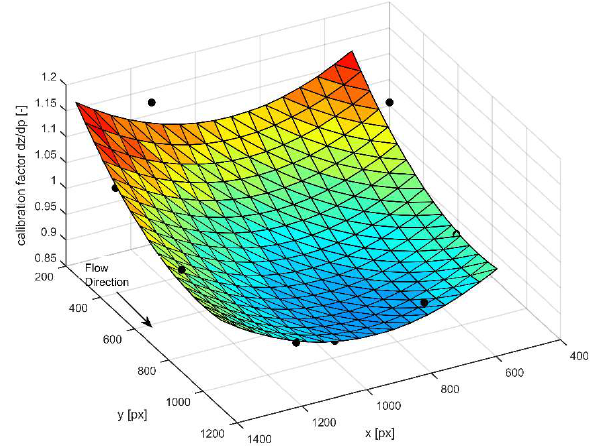
Figure 3. Calibration factor for the vertical scaling from pixel into metric scale of the distorted camera images. The plotted points ( n = 12) represent the measurements while the mesh represents their spatial interpolation.